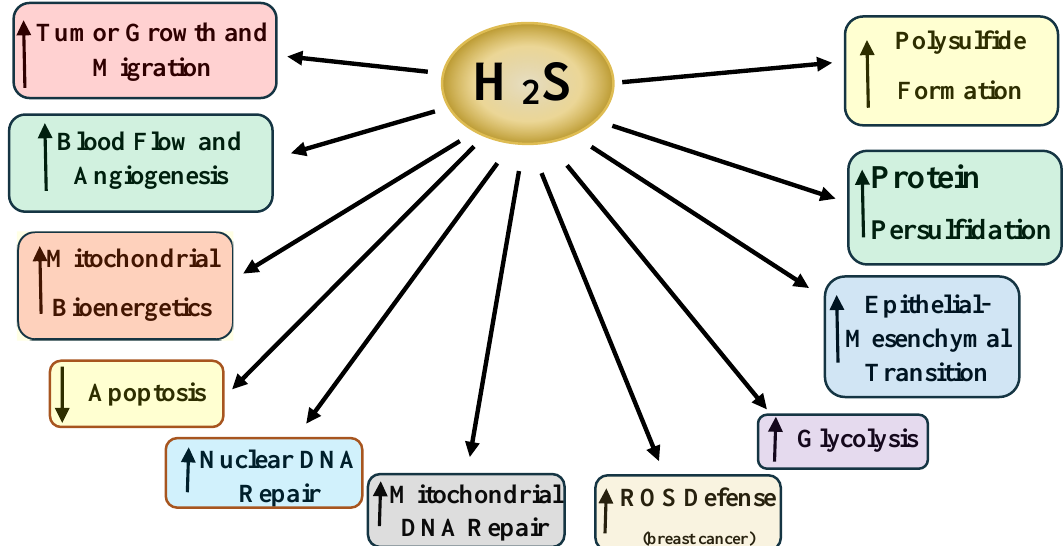
Figure 4. A synopsis of some of the cancer-promoting effects of H2S in cancer. Together, these events function together to increase tumor grade and stage, increase metastatic potential, and confer chemotherapy resistance.